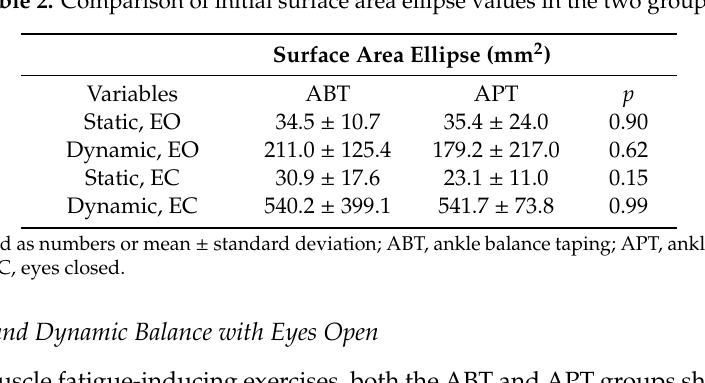
Table 2. Comparison of initial surface area ellipse values in the two